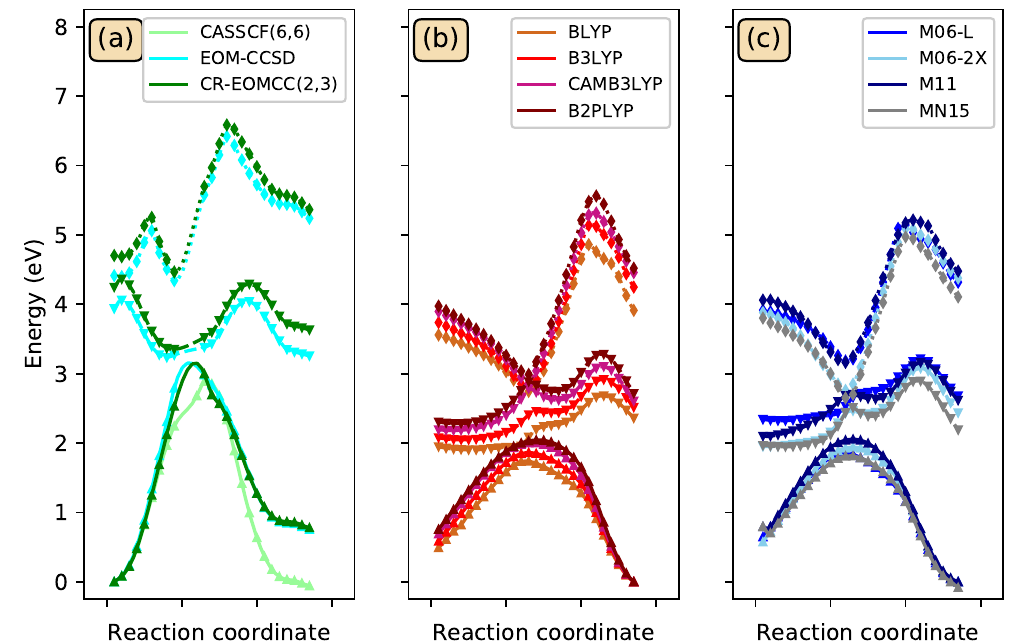
Figure 4. Reaction profiles for the ring-opening of silylsilacyclopropenylidene (isomer 2 ) to (silylethynyl)silylene, as computed using ( a ) wave-function methods, ( b ) BLYP-based DFT methods, and ( c ) Minnesota DFT methods. Solid ( (cid:115) ), dashed ( (cid:116) ), and dotted ( (cid:169) ) lines (symbols) correspond to the ground, first-excited, and second-excited states,